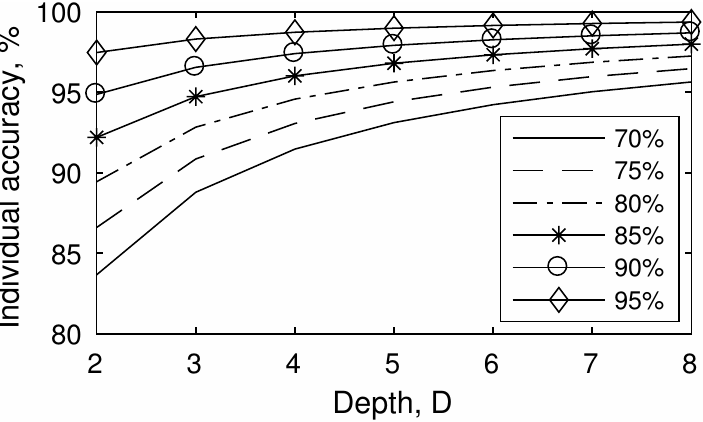
Figure 6. Individual accuracies according to total